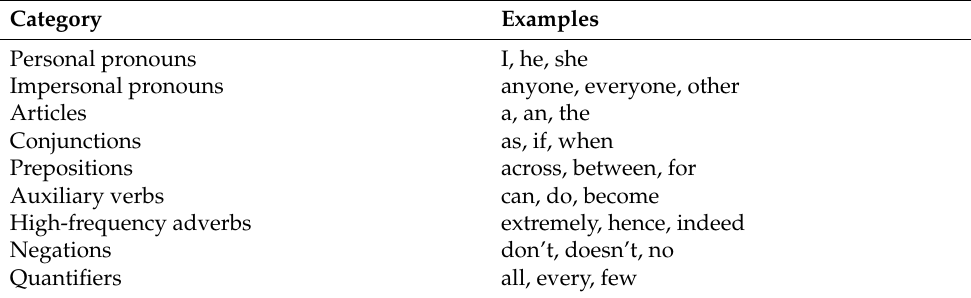
Table 2. LSM categories and sample